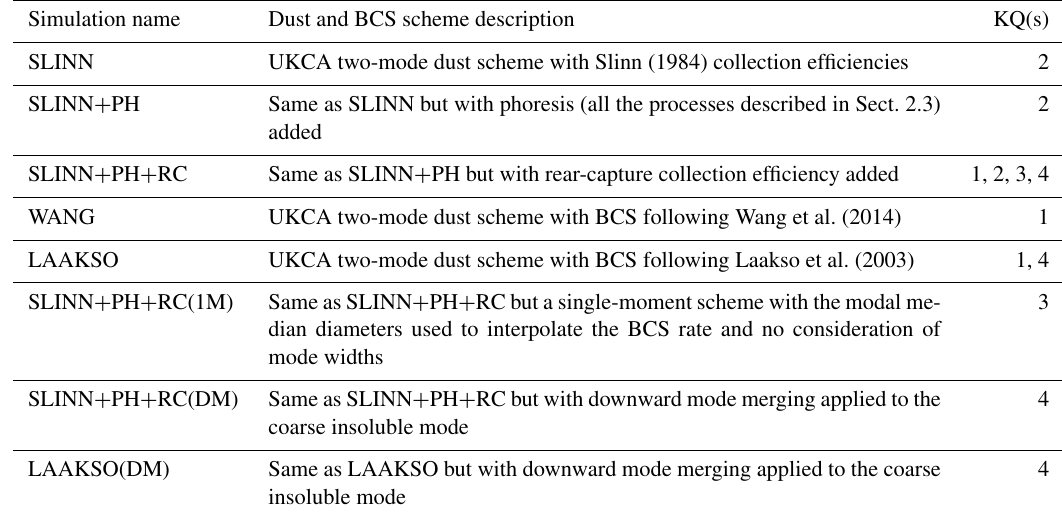
Table 1. Description of the UM-GA8.0 simulations performed and the key questions (KQs) addressed by each simulation. Simulation